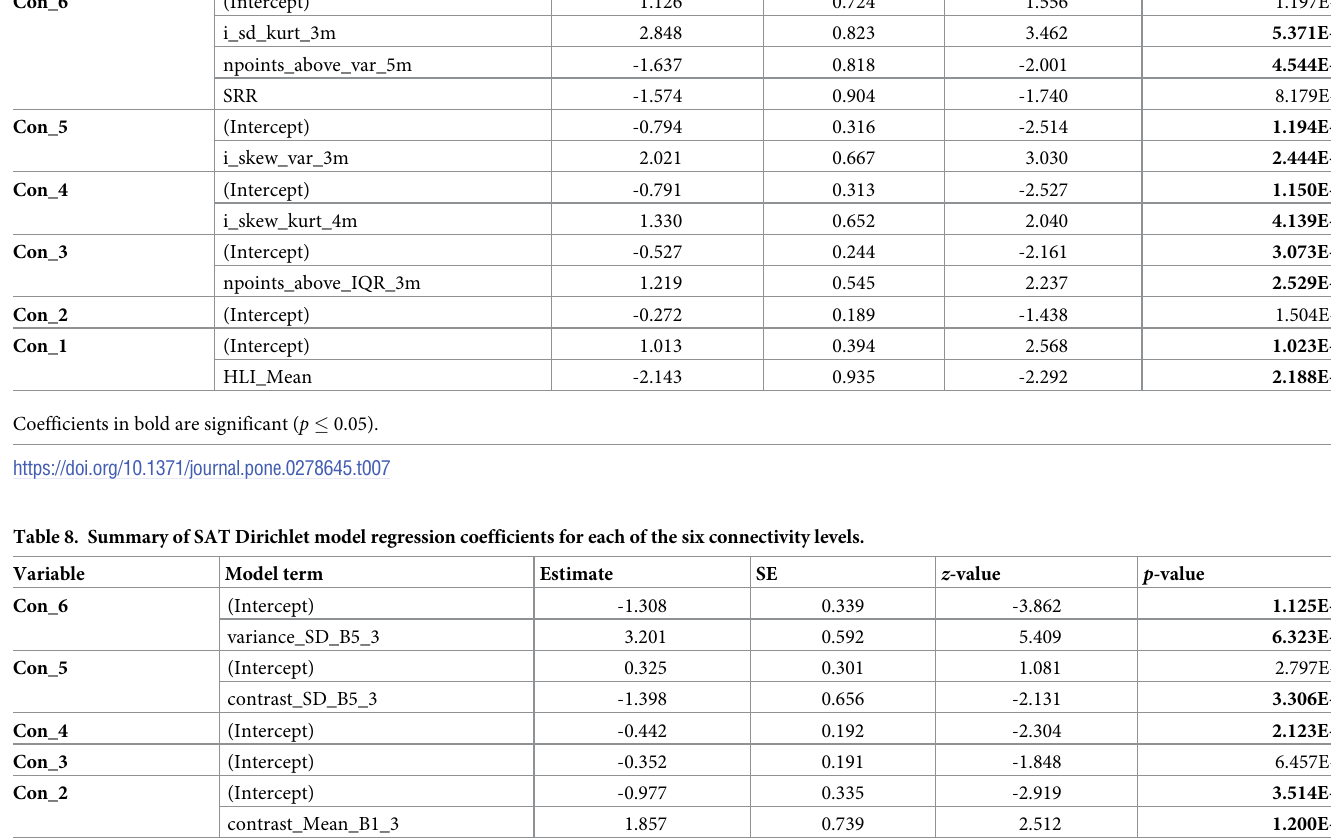
Table 7. Summary of LID Dirichlet model regression coefficients for each of the six connectivity levels. Variable